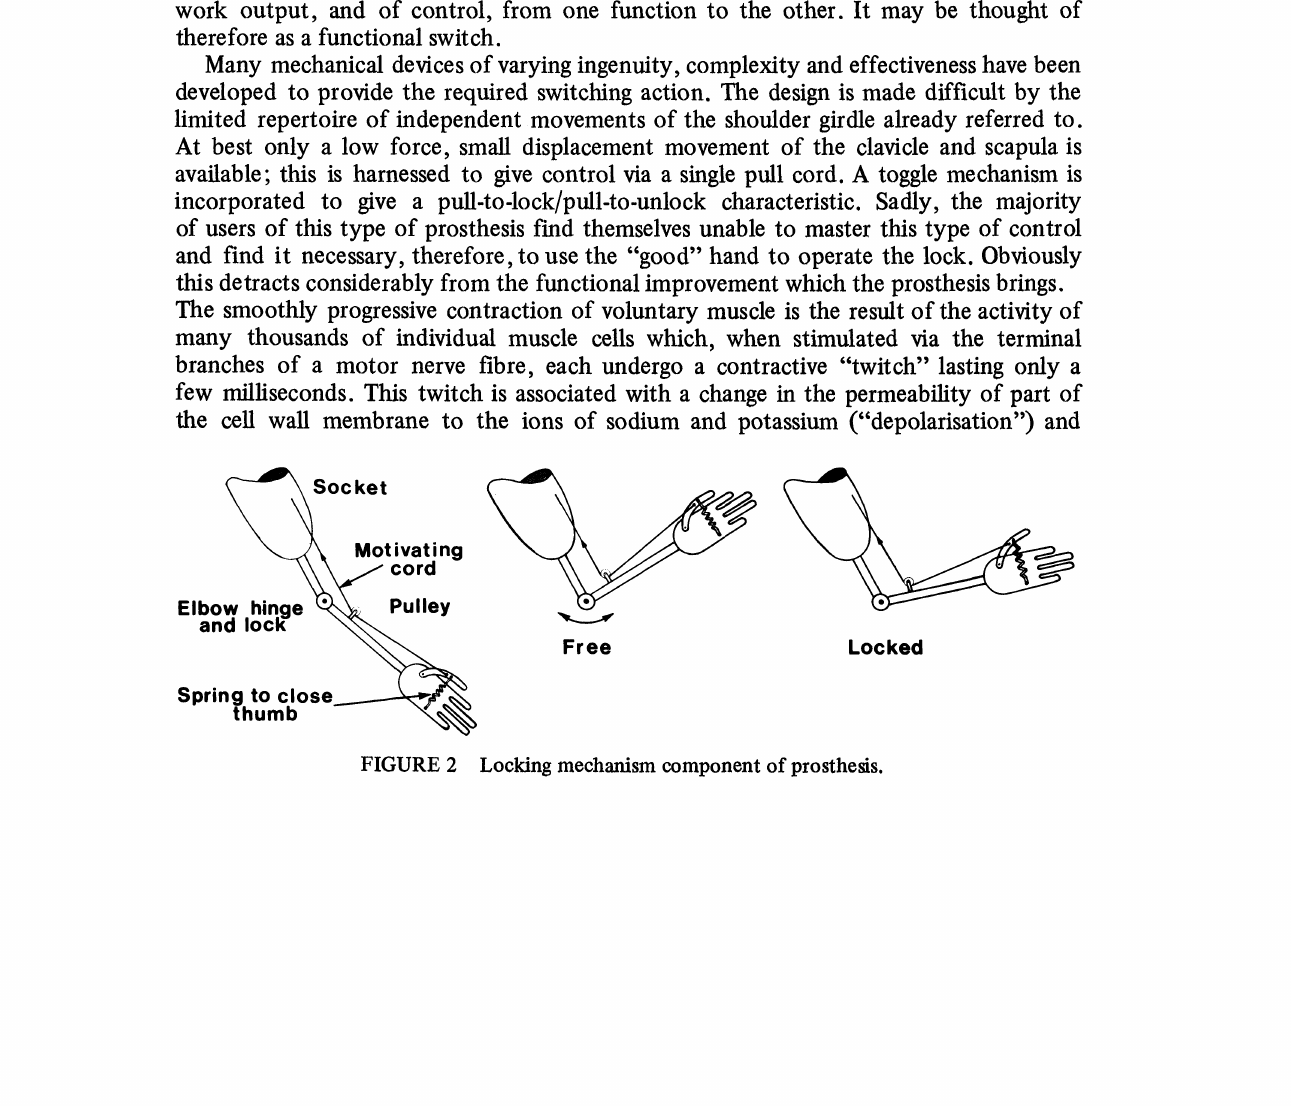
FIGURE Prosthesis fitted to upper-arm amputee.